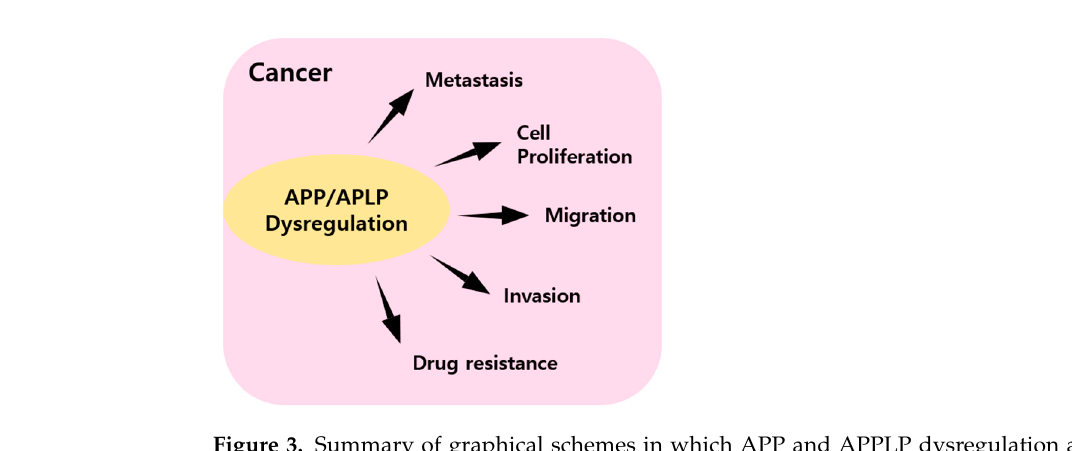
Figure 3. Summary of graphical schemes in which APP and APPLP dysregulation affect cancer metastasis, cell proliferation, migration, invasion, and drug resistance.